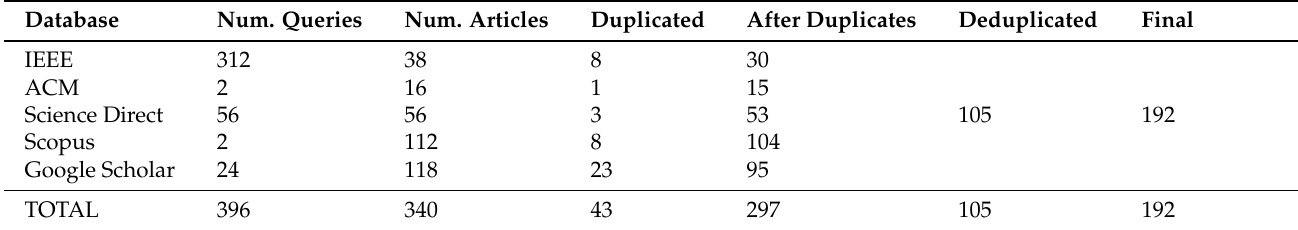
Table 5. Number of articles obtained after query